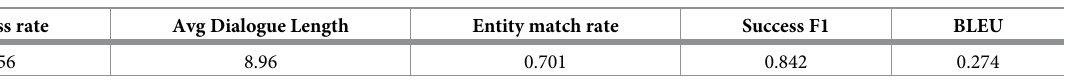
Table 12. TSCP model performance for dynamic goal setting